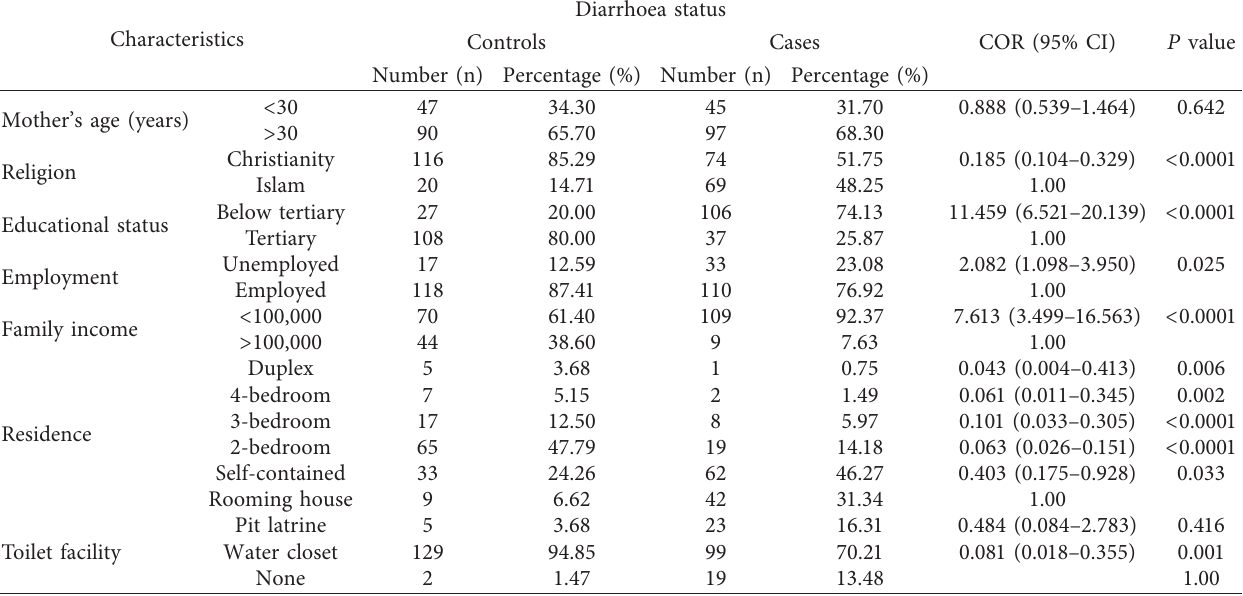
Table 2: Association between demographic and socioeconomic variables of mothers/caregivers and diarrhoea.